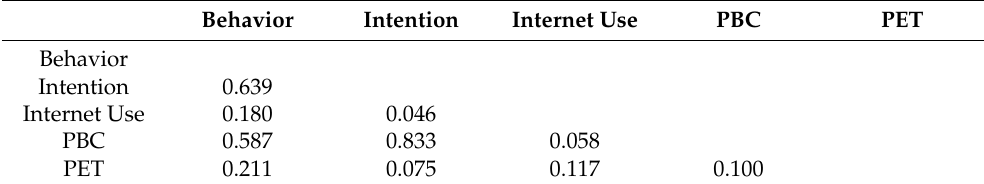
Table 4. Discriminant